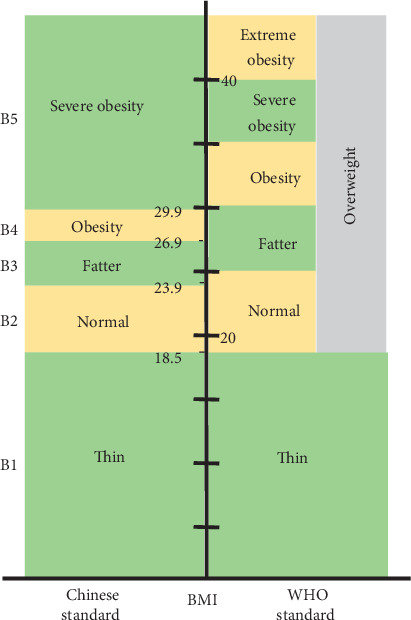
BMI classification.